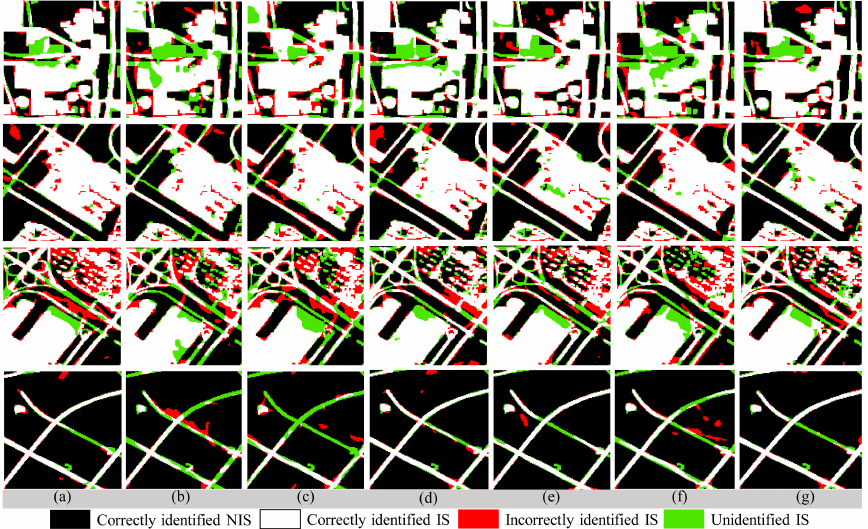
Figure 9. Impervious surface extraction results based on UNet with various features. ( a – g )